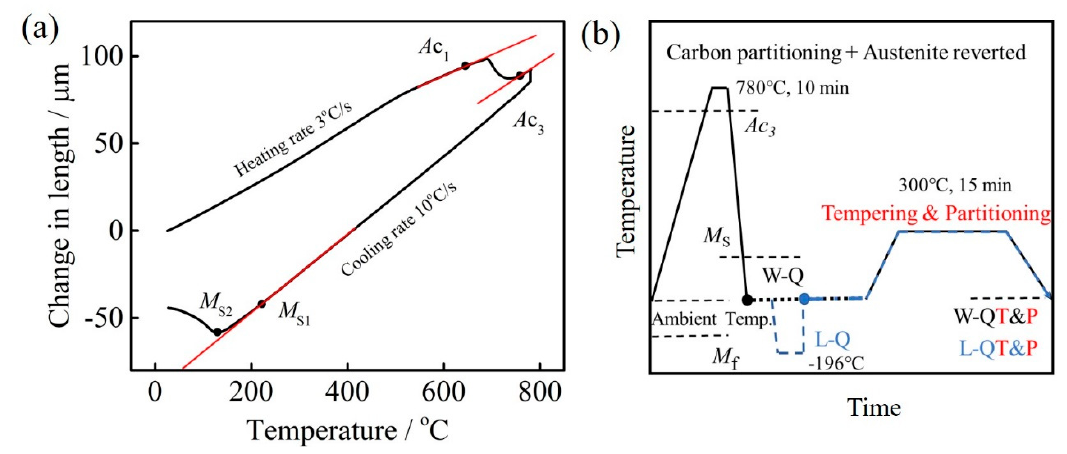
Figure 1. ( a ) Dilatometric curve of the experimental steel after thermal cycle. A c 1 , A c 3 , M S1 and M S2 are austenite-start temperature, austenite-finish temperature, martensite-start temperature, and massive martensite-start temperature, respectively, and ( b ) the schematic diagram of the heat treatments. X-ray di ff raction (XRD) was used to measure the volume fraction of retained austenite and carbon concentration in retained austenite [21]. The XRD experiments were conducted using a D / max2400X-ray di ff ractometer (operated at 56 kV, 182 mA) with Cu K α radiation at room temperature and the samples ◦ ◦ ◦ / were scanned over a 2 θ range from 40 to 100 with a step size of 2 min that included ferrite and austenite peaks. The microstructure was characterized by transmission electron microscope (TEM) (Tecnai G2F20, FEI, Hillsboro, OR, USA). Both TEM images were acquired at an accelerating voltage of 200 kV. Electron backscatter di ff raction (EBSD) (Symmetry, Oxford Instruments, Oxford, UK) maps were obtained at a step size of 0.05 µ m and analyzed using the MTEX (version 5.28, Ralf Hielscher,